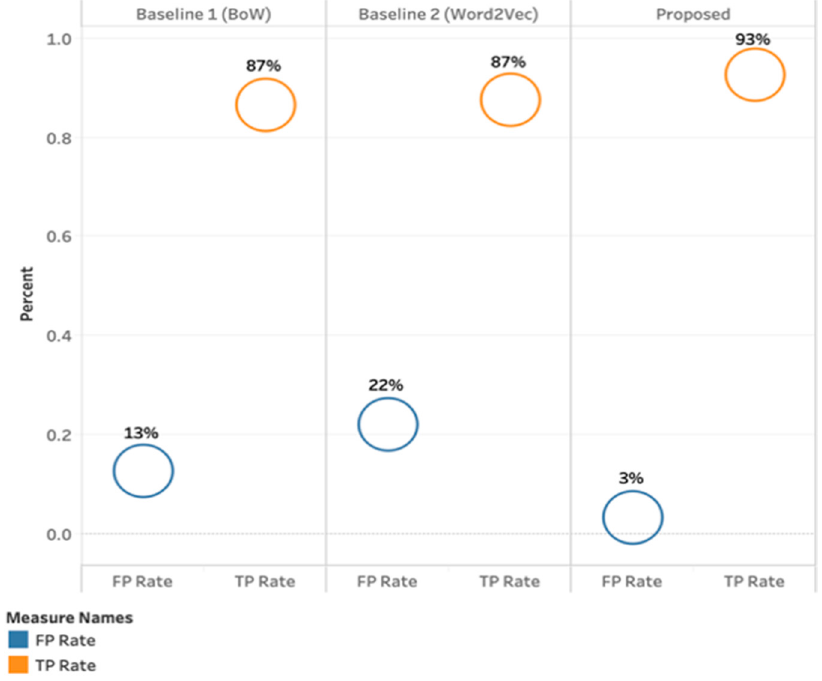
Figure 8. True and False positive rate for baseline and the proposed approach.